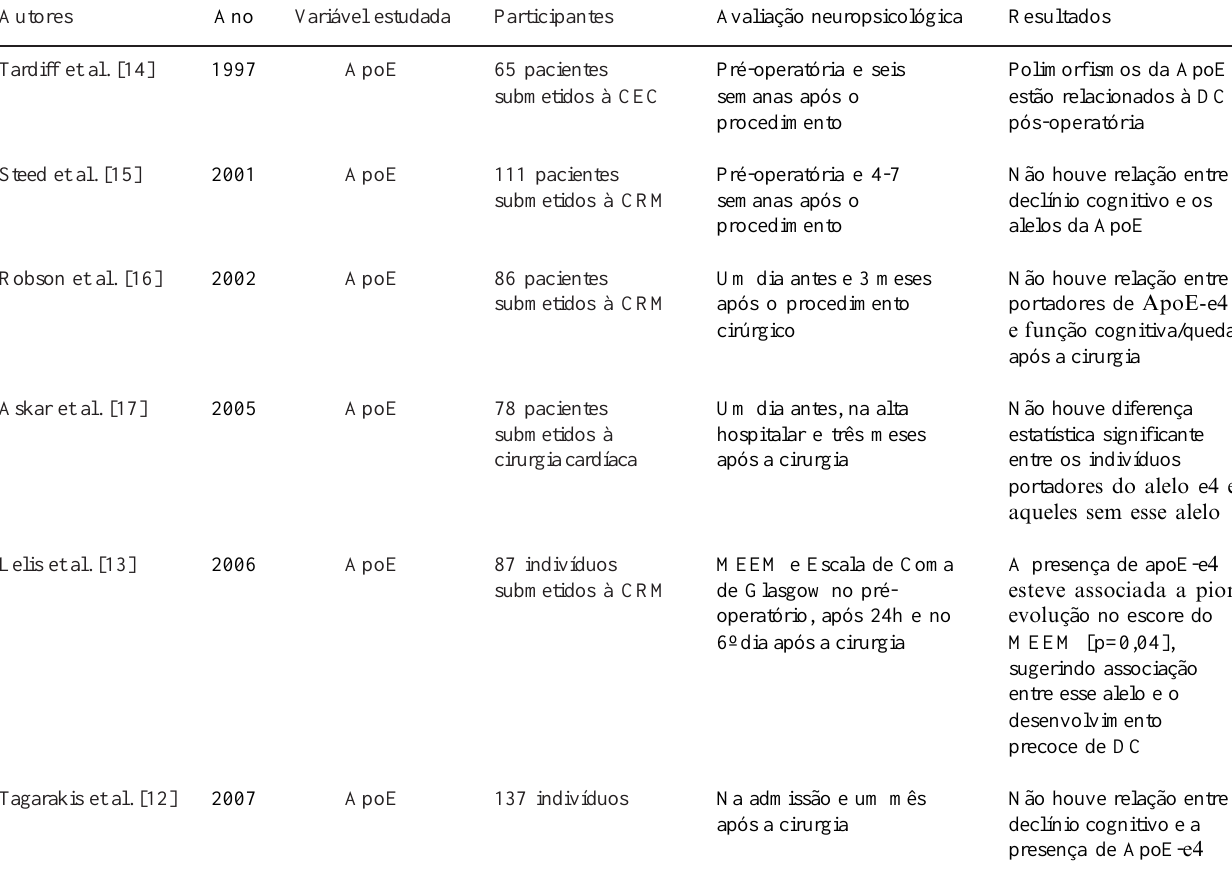
Tabela 4. Fatores